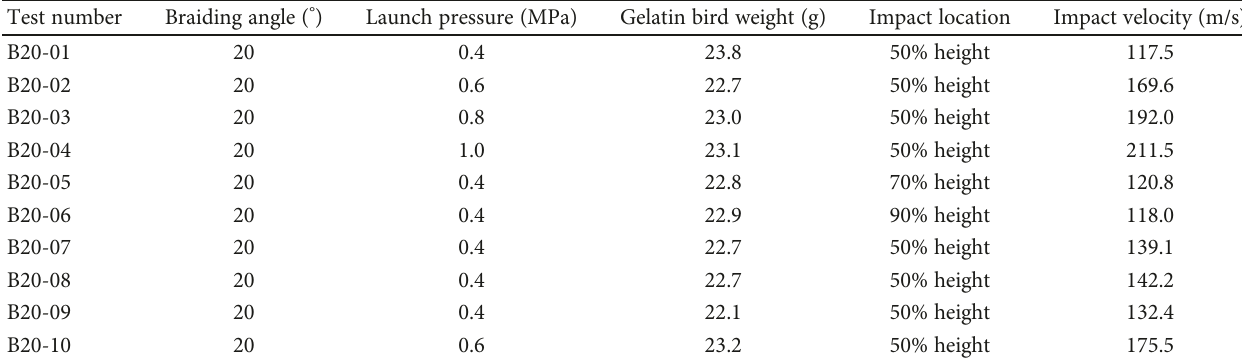
Table 1: Bird impact test conditions on composites of 20 ° braiding